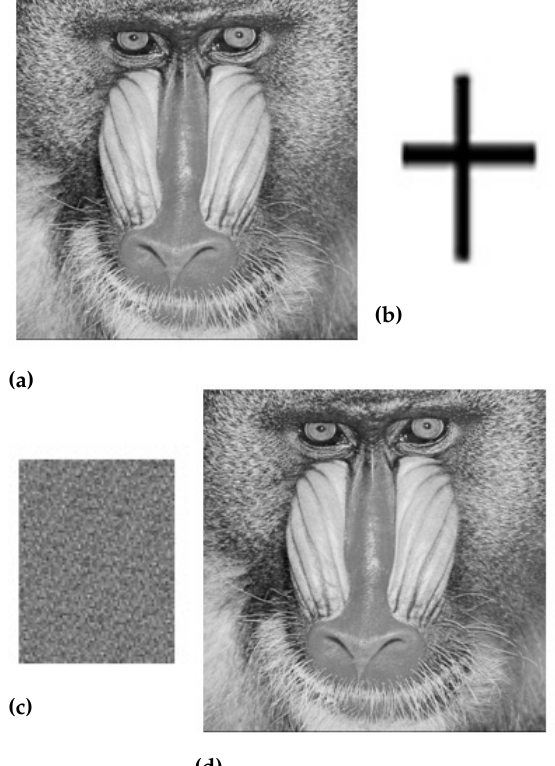
Figure 8. ( a ) Original baboon image, ( b ) Watermark image, ( c ) Scrambled image, and ( d ) Watermarked baboon image.